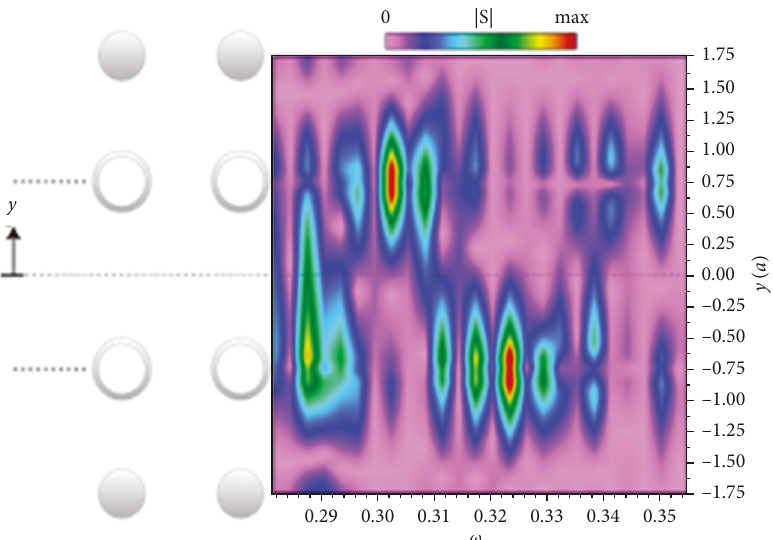
Figure 6: (Color online) variation of the modulus of the Poynting vector with vertical position and frequency at the output interface of the interacting PC surfaces with